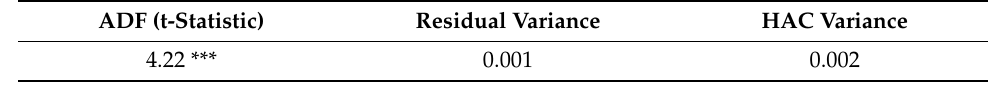
Table 7 states the Kao test results. The Pedroni [29] test evaluates uniform cointegration relationships through pooled regression and considers each fixed effect. We used the ADF panel cointegration test to prove that the cointegration vector is consistent, and the test revealed cointegration between specific variables. Table 8 states the fisher test results Table 7. Kao (Engle-Granger based) test results. ADF (t-Statistic)